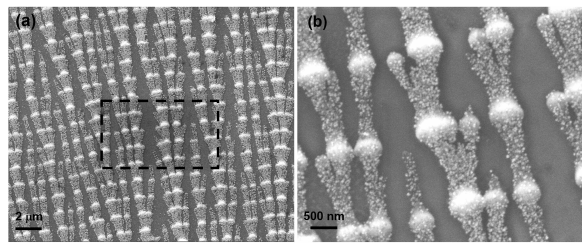
Fig. 2. SEM images of Cu 2 O/NiO nanoarrays (a) and magnified image of Cu 2 O/NiO nanoarrays